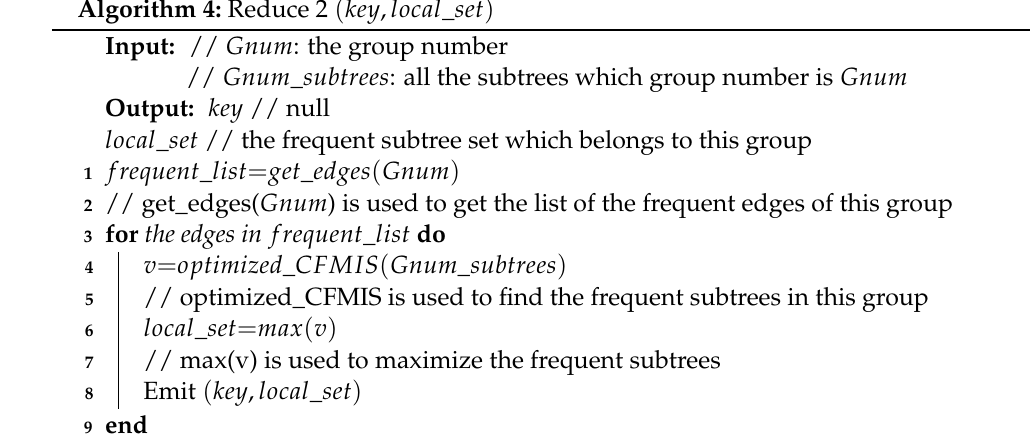
Algorithm 4: Reduce 2 ( key , local _ set